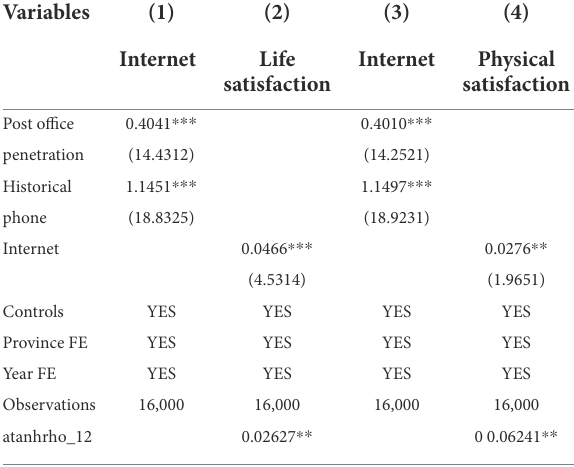
TABLE 4 Endogenous processing: